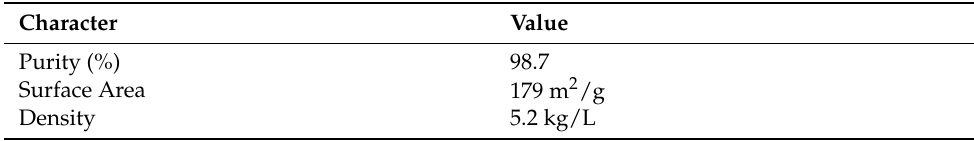
Table 3. Characterization of iron oxide